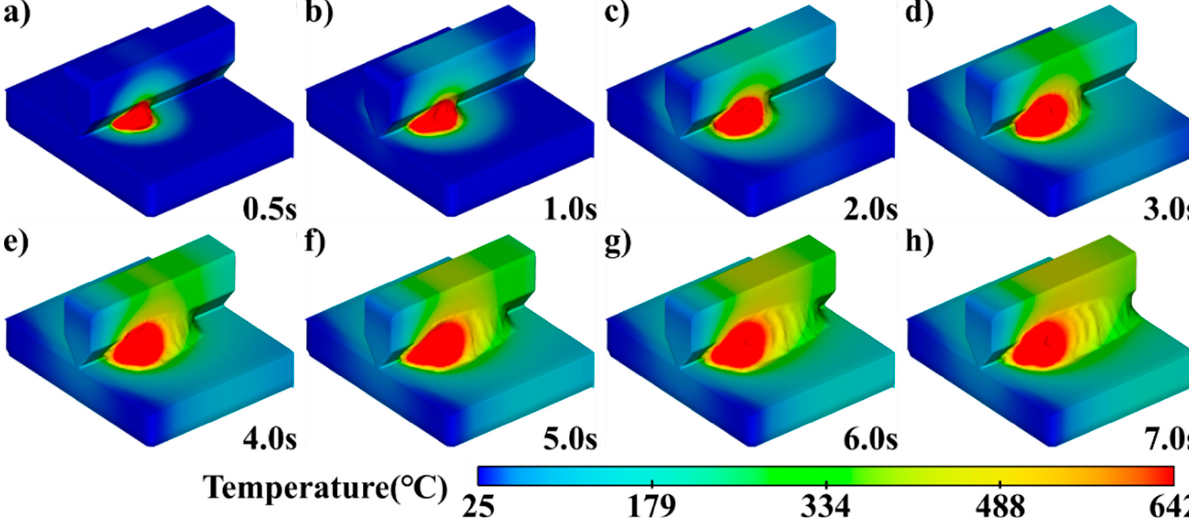
Figure 5. Weld bead formation process: weld bead appearance visualized by temperature contours at ( a ) 0.5 s, ( b ) 1.0 s, ( c )